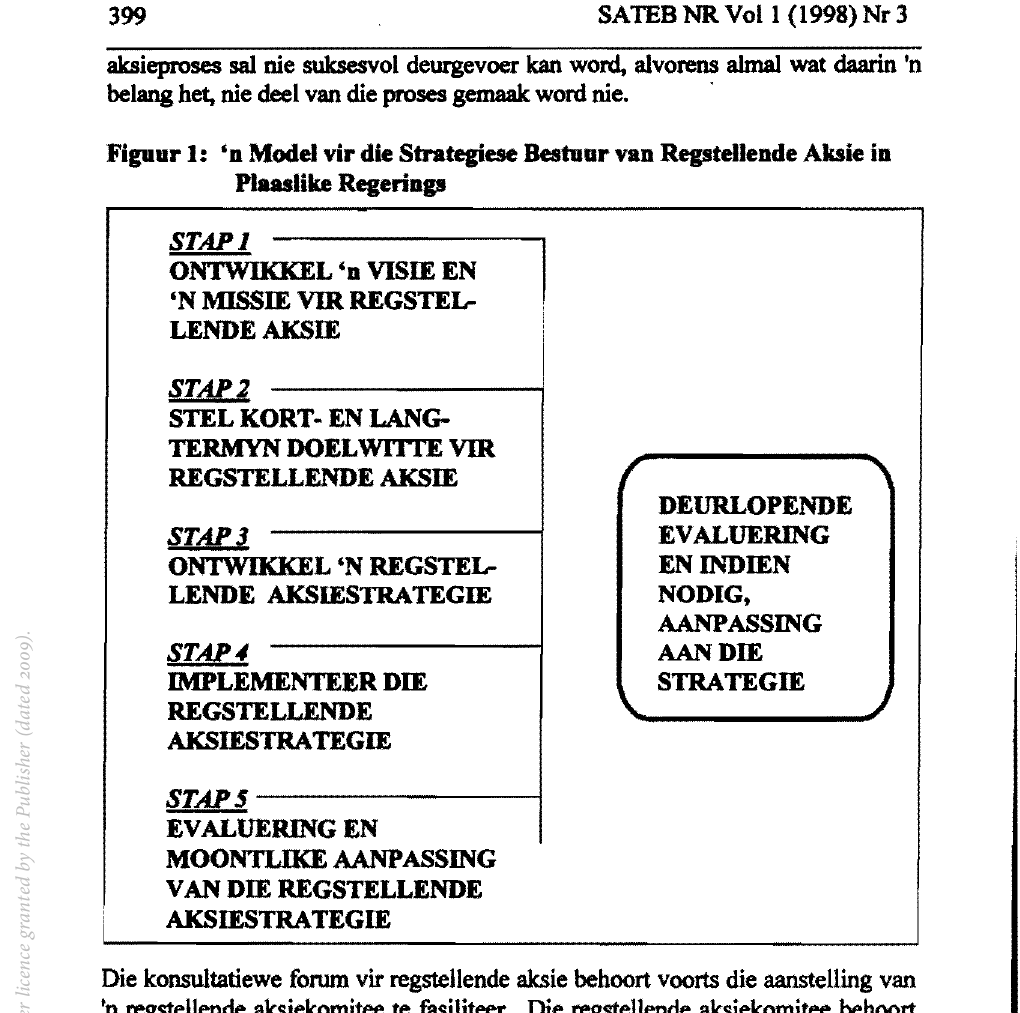
Figuur 1: 'n Model vir die Strategiese Bestuur van Regstellende Aksie